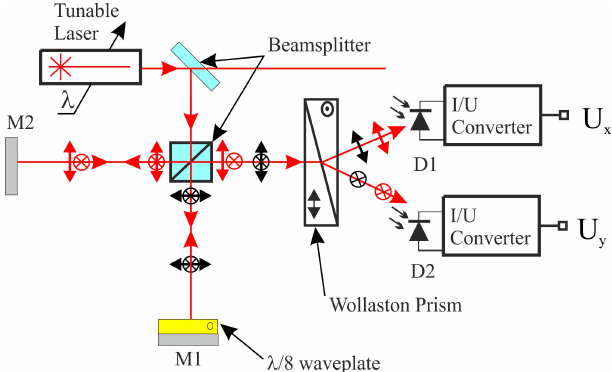
Figure 1. Polarization interferometer for measurement of change in the wavelength of a tunable semiconductor laser. D1, D2—photodiodes, M1, M2—mirrors, U x , U y —output